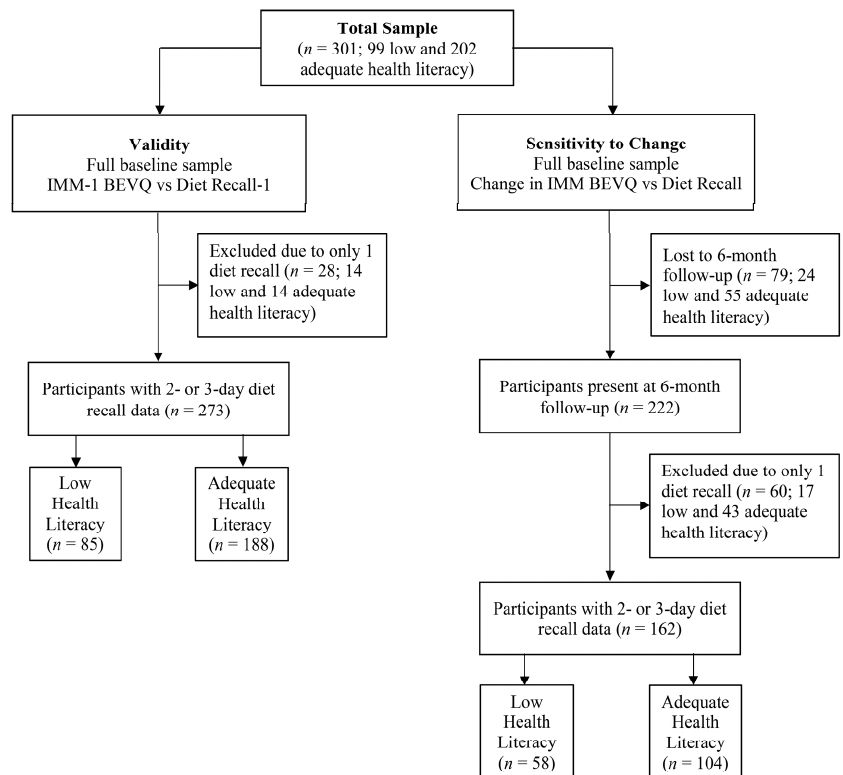
Figure 3. Flow Diagram of Analytical Sample Size.